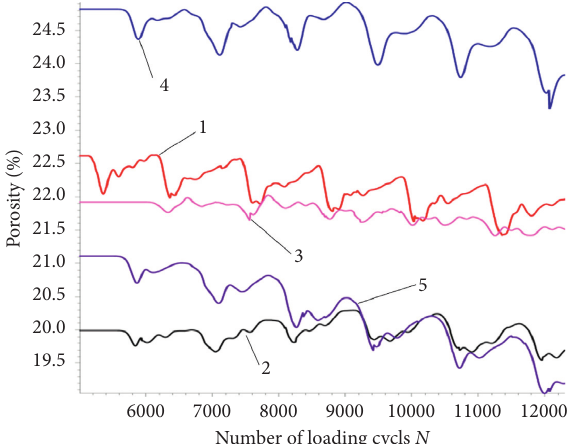
Figure 12: Variation of porosity at different measurement